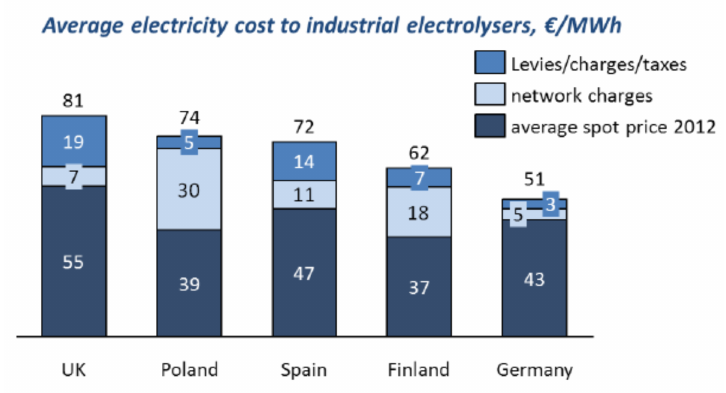
Figure 2. Average electricity cost of industrial electrolyzers in 2012